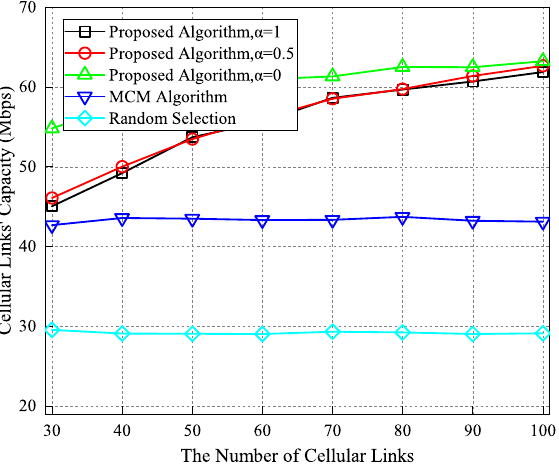
Figure 7. The total capacity performance of different schemes with varying V2I